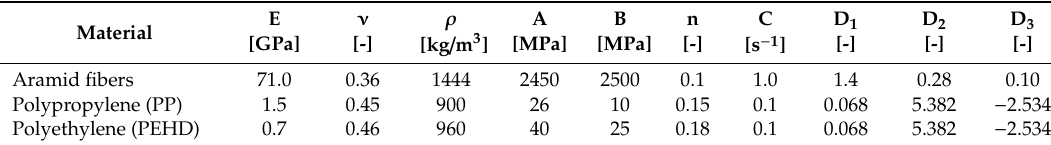
Table 3. Material properties of the panel [44,45,47].